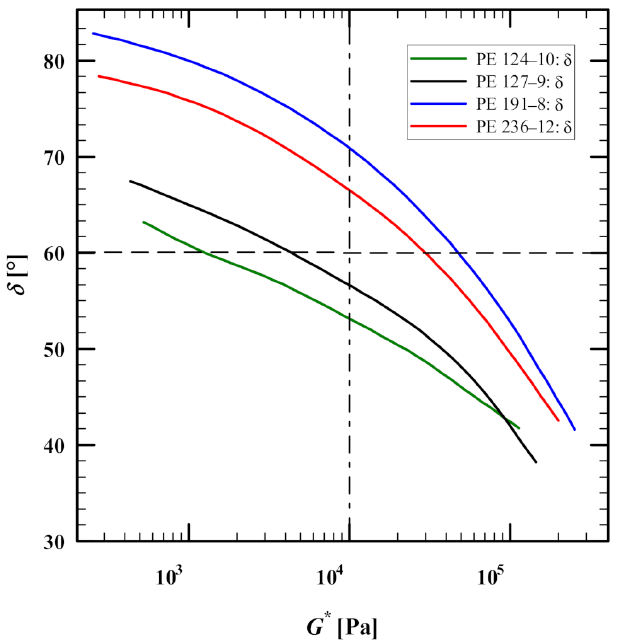
Figure 2. Van Gurp-Palmen plot for PE 191-8, PE 127-9, PE 124-10 and PE 236-12 at 160 ◦ C produced in the IRIS software [32] using storage ( G (cid:48) ) and loss ( G (cid:48)(cid:48) ) moduli data from Morelly and Alvarez [23]. Horizontal (dashed) and vertical (dashed-dotted) lines denote the complex modulus at δ = 60 (for PDI), and loss angle at G* = 10 kPa (for LCBI, Equation